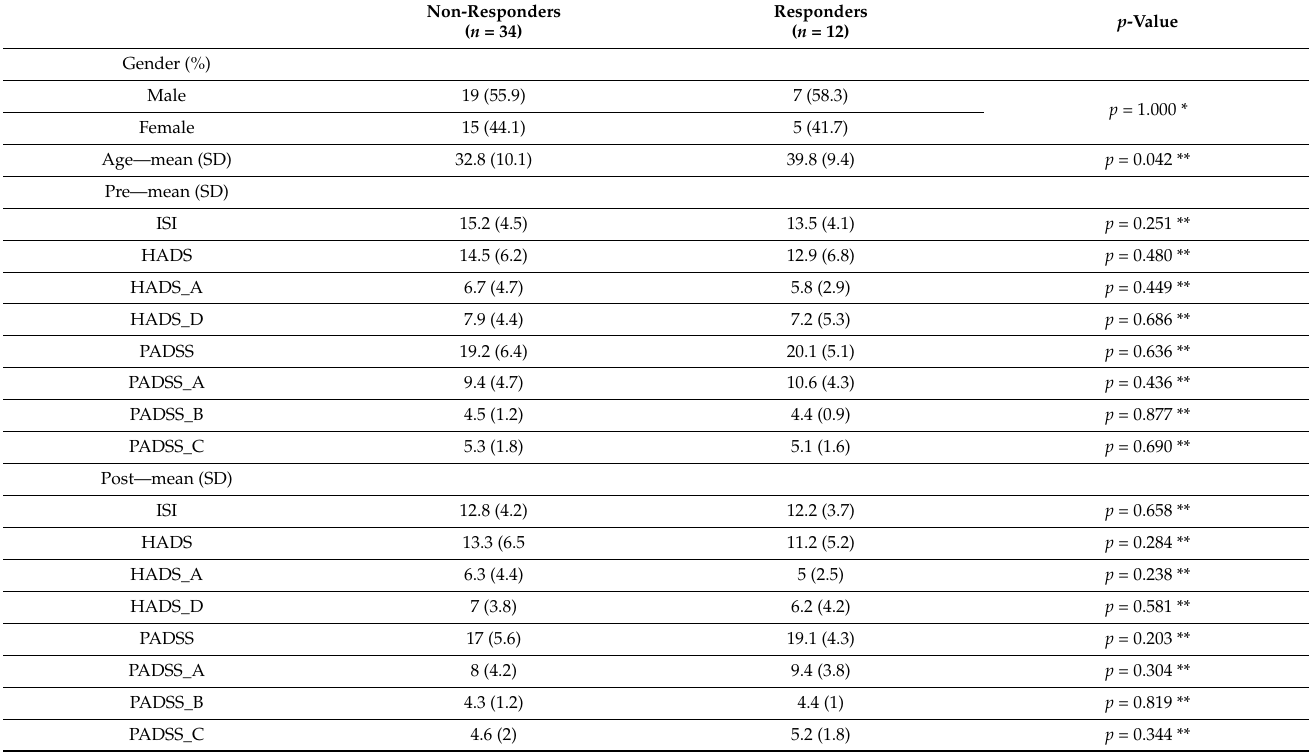
Table 4. Comparison of demographics and scales of ISI, HADS and PADSS between responders and non-responders.